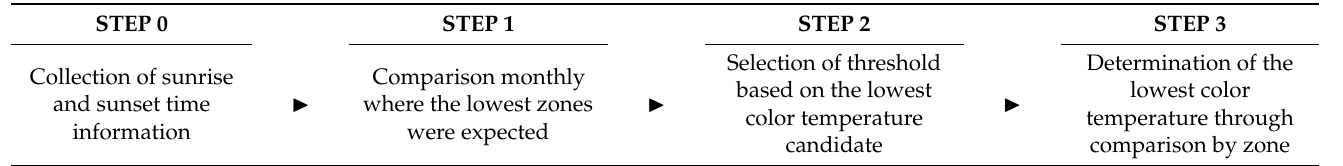
Table 2. The process of finding the lowest point of color temperature .